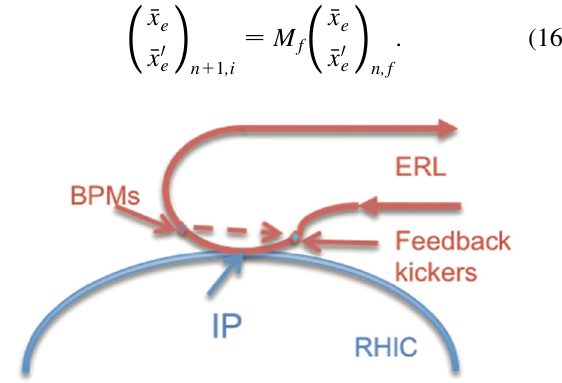
FIG. 6. The schematic layout of the feedback system for mitigating the kink instability in